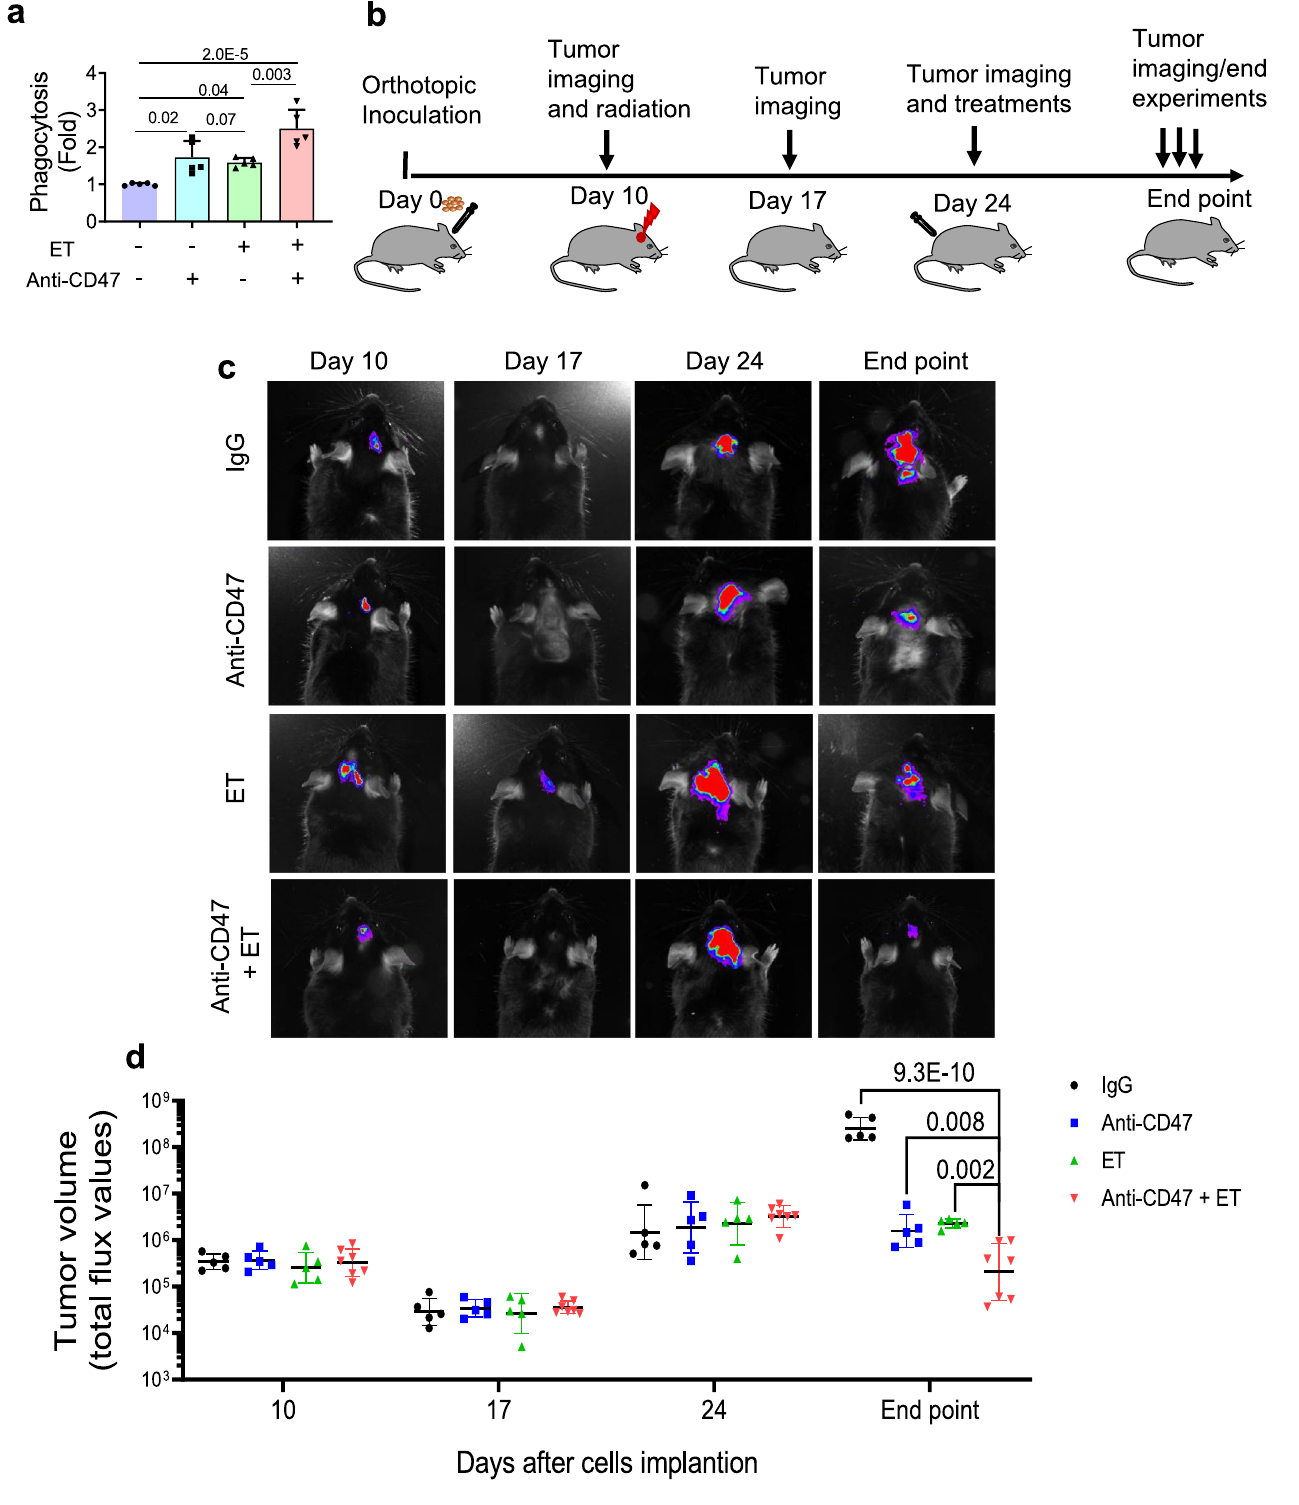
standard guidelines with free access to food and water. All experiments were performed on 6 weeks old female C57BL/6 mice (Taconic) or 6 weeks old female nude mice (The Jackson Laboratory, Stock No:002019). Animals including litter- mates of the same sex were randomly assigned to control or treatment conditions. deparaf fi nization and rehydration, antigen retrieval was conducted with